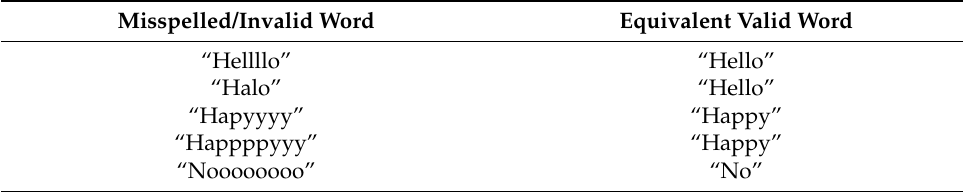
Table 2. Mapping of misspelled/invalid word into equivalent valid